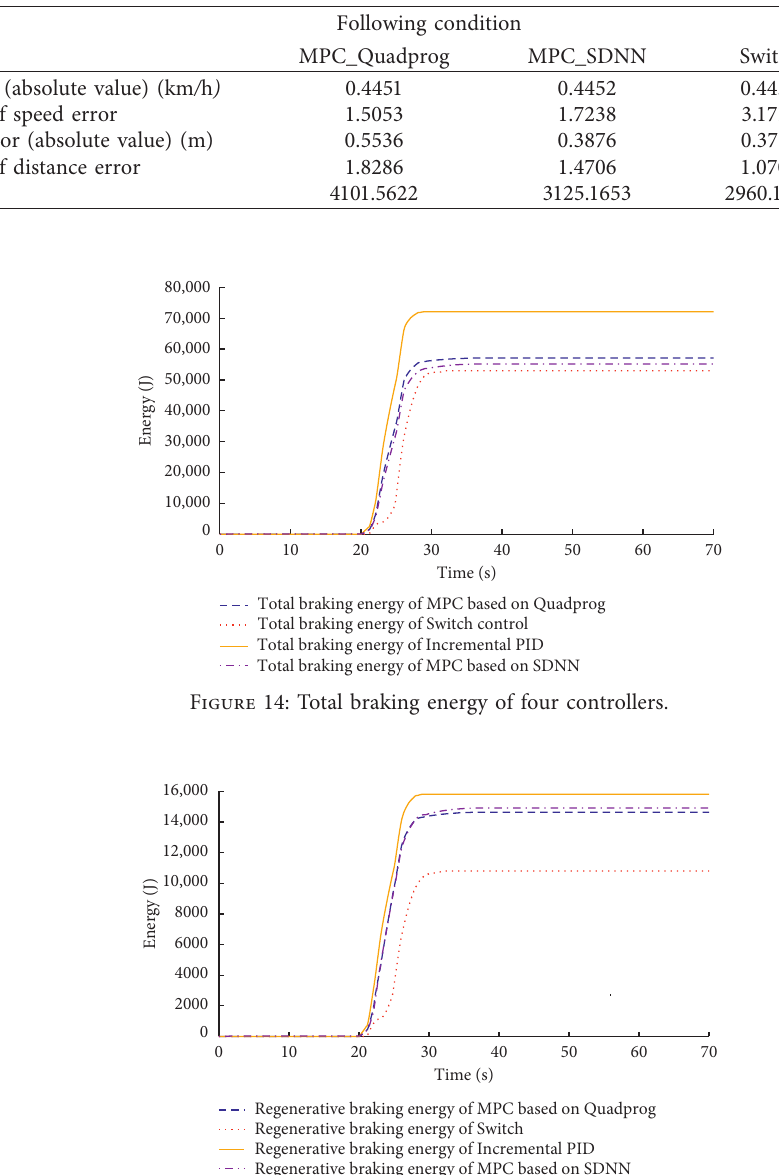
Table 11: Performance in the following condition.